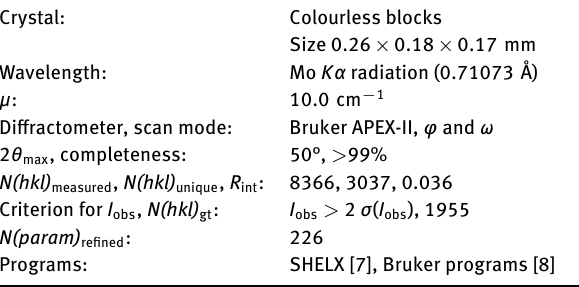
Table 2: Fractional atomic coordinates and isotropic or